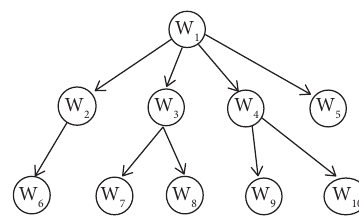
Figure 2: The priority graph of the project.